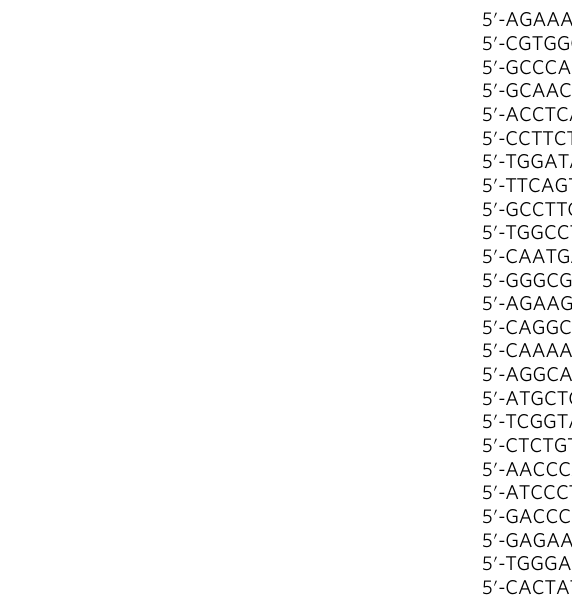
Table 2 Oligo sequences used for qPCR